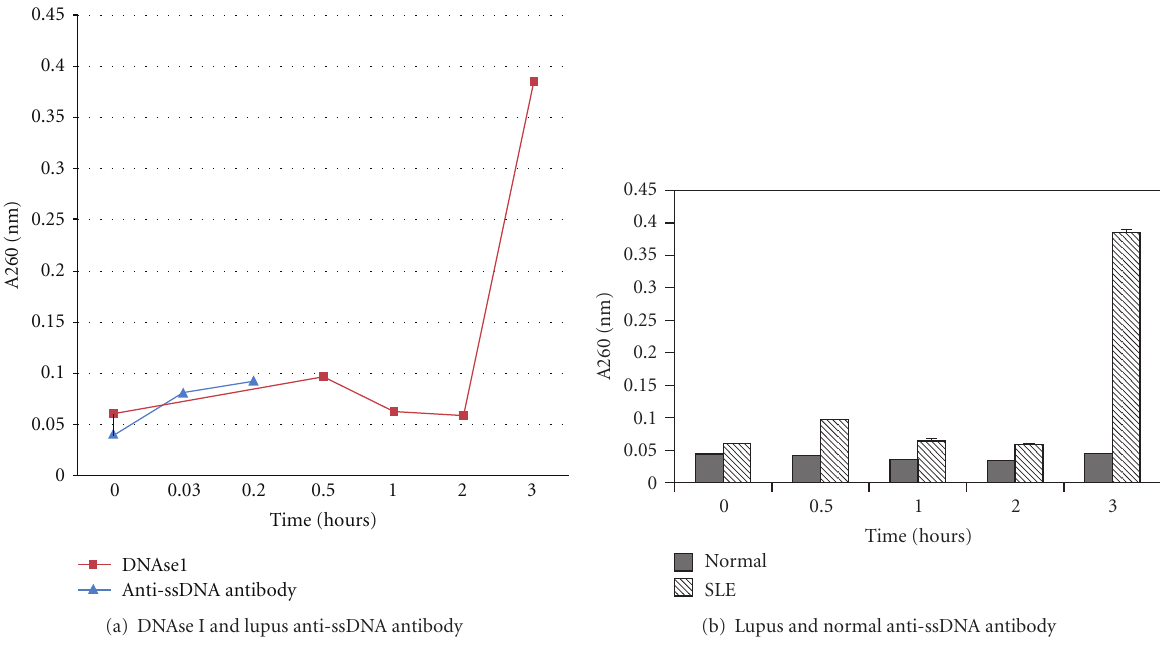
antibodyTime DNAse1 Anti-ssDNA (b) Lupus and normal anti-ssDNA antibody Figure 4: Discontinuous measurement of hydrolysis of oligo 18-mer by DNAse I, lupus patient, and normal donor anti-ssDNA antibody by UV spectrophotometry. ∗ 5 (cid:3) -6-FAM-ATATAGCGC 5 T 5 -DQ1-3 (cid:3) 18-mer hydrolysis probe was incubated with DNAse I or anti-ssDNA antibody purified from lupus patient or normal healthy donor serum. Analysis by UV spectrophotometry demonstrates a change in A260 reading after 3 hours indicating hydrolysis by lupus anti-poly-(dT) ssDNA antibody. Normal healthy donor-derived anti-poly-(dT) ssDNA antibody does not display hydrolytic activity. No change was seen in replicates containing bu ff er only and those containing substrate only throughout the trials. Endpoint analysis via one-way ANOVA comparing hydrolytic activity revealed a significant di ff erence between activity of antibody purified from lupus patients and normal donors ( F = 5465.06, P < 0 . 0001). (a) Determination of ability of DNAse I and lupus anti-ssDNA antibody to hydrolyze probe by UV spectrophotometry. The DNAse reaction peaks after approximately 15 minutes and comes to completion in 30 minutes. Activity starts at 0.03 hour, peaks at 0.2 hours, and subsides at 0.5 hours and is much faster than DNA hydrolysis by anti-ssDNA antibody isolated from SLE patient serum. (b) Comparison of ability of purified lupus and normal anti-ssDNA antibodies to hydrolyze probe by UV spectrophotometry. Anti-ssDNA antibodies isolated from normal donors did not demonstrate hydrolytic activity; however, anti-ssDNA antibodies isolated from SLE patients show cleavage ability during the 3 hour incubation time point. These results were consistent across all samples analyzed. ∗ P < 0 . 01 for normal individuals versus SLE